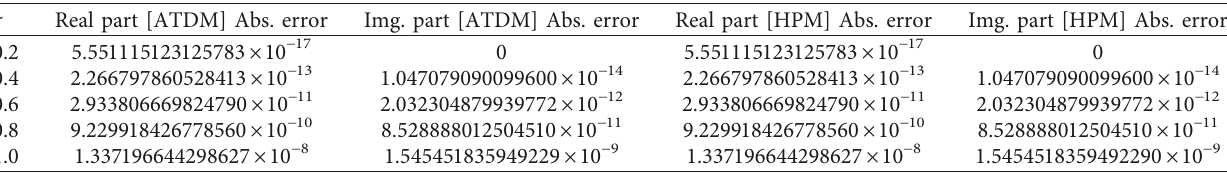
Table 3: The absolute error in ATDM and HPM for Example 3 at ] � 1.